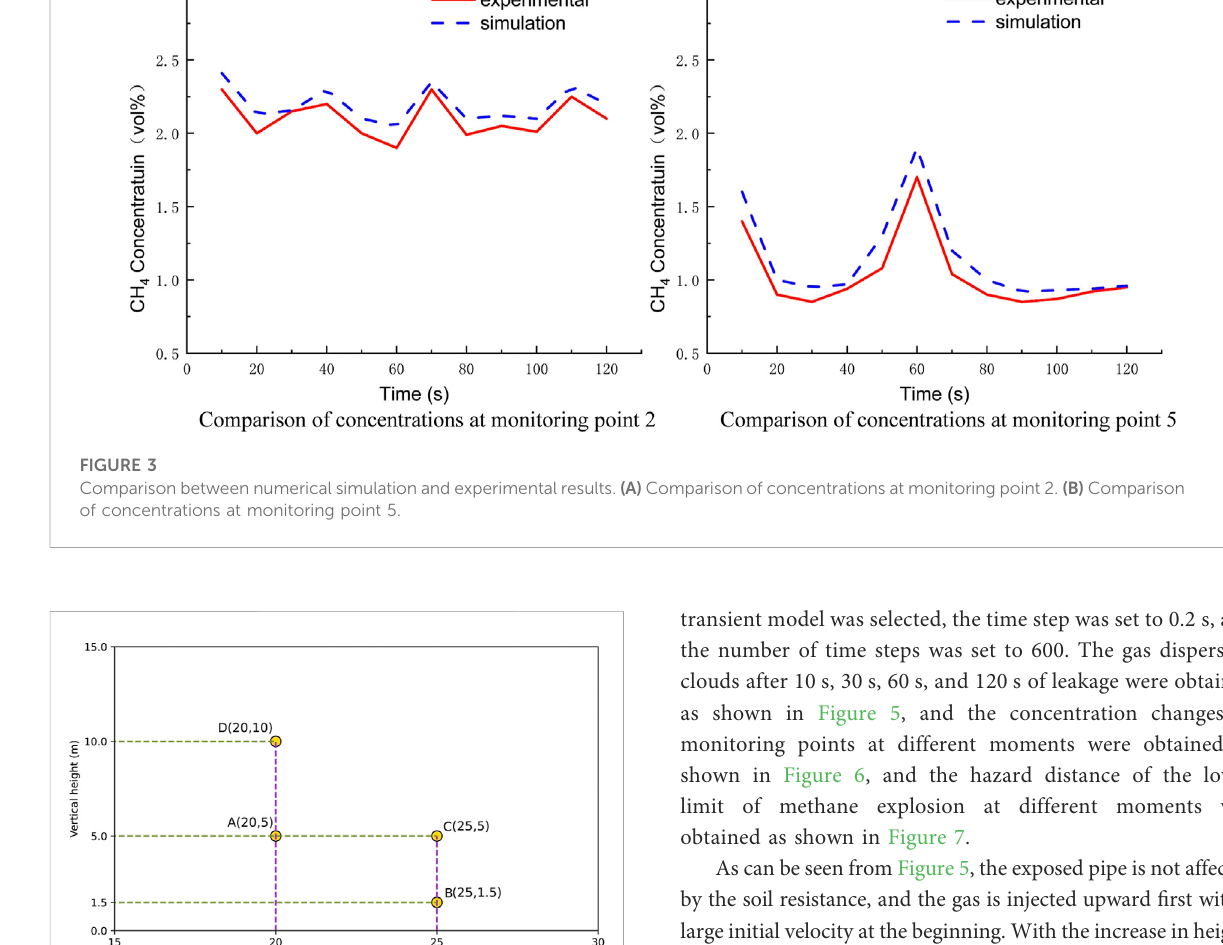
FIGURE 4 Location diagram of monitoring